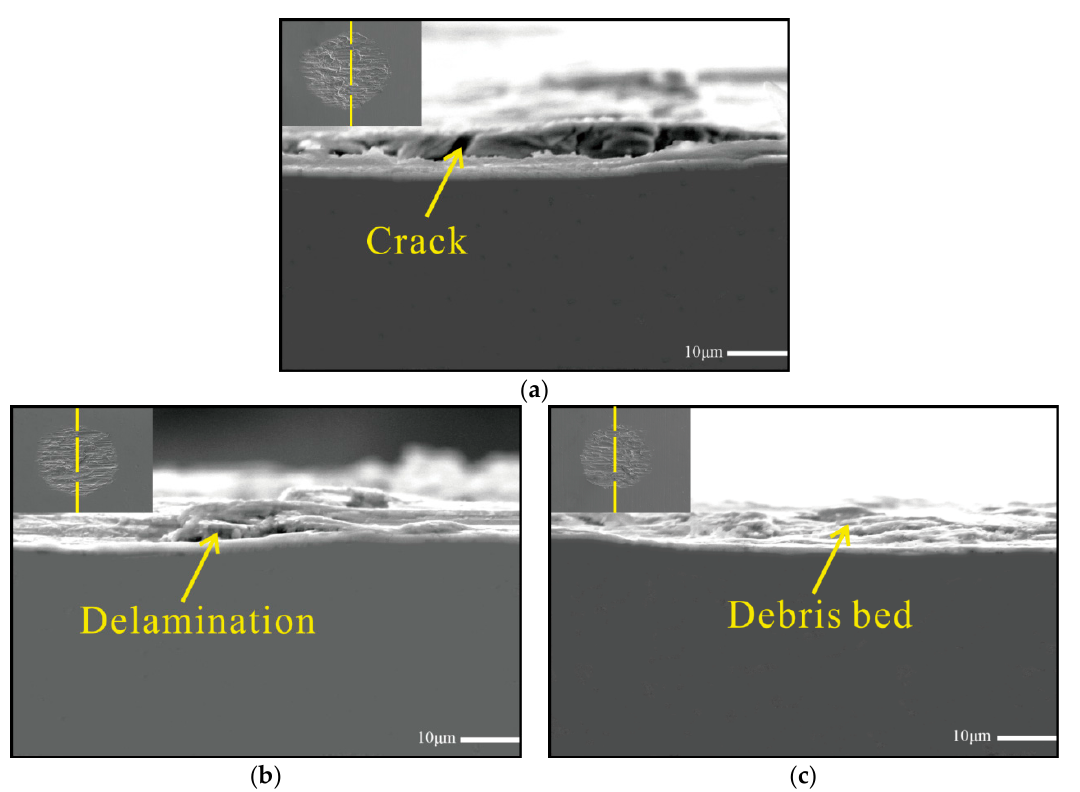
Figure 10. Cross-section morphology of worn scars: N = 3000. ( a ) Untreated; ( b ) 5 J treated; ( c ) 7 J treated.